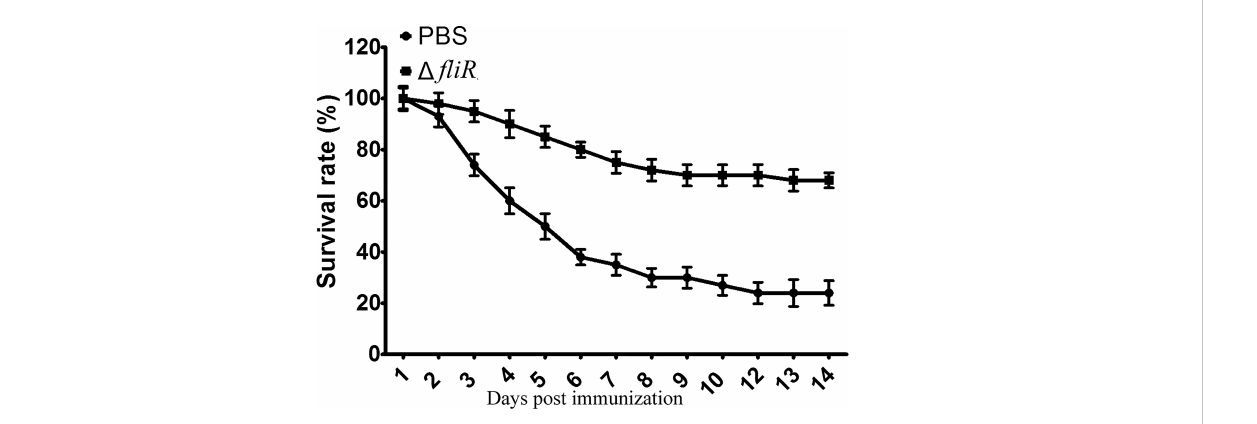
FIGURE 5 Determination of the immune protection rate of the fl iR mutant strain against grouper. After infection with the wild-type strain, the control group had a signi fi cantly higher mortality rate three days after injection than the immunized group, with 68.45% and 24.54% mortality in the control and immunized groups, respectively.